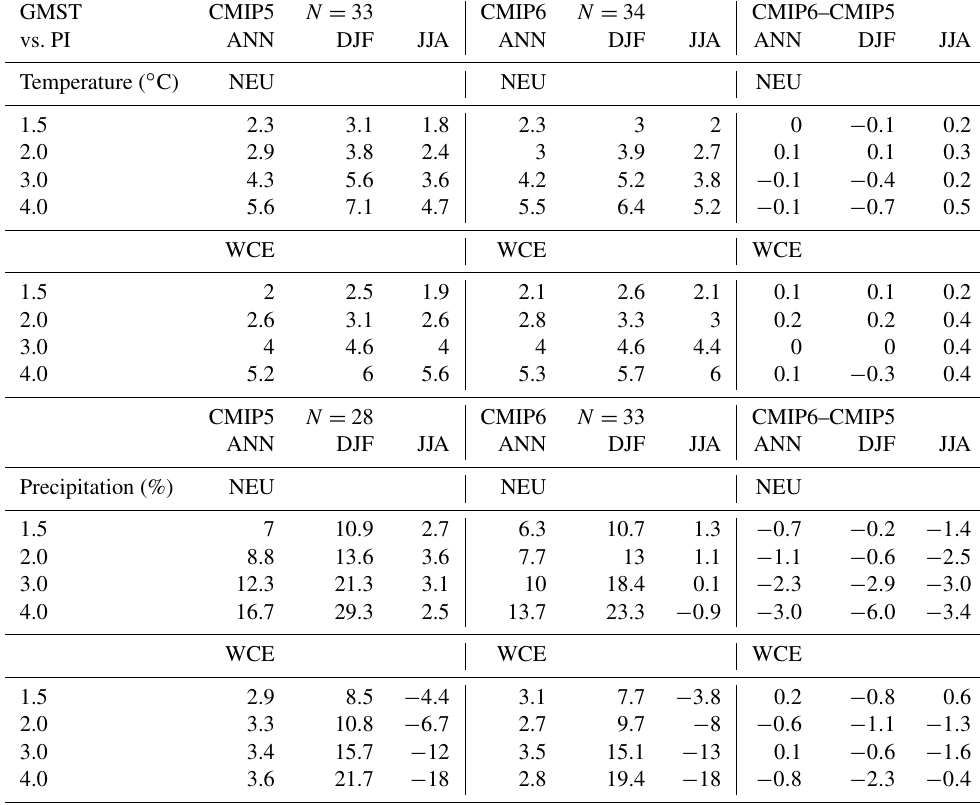
Table 6. Ensemble mean changes in temperature (degrees Celsius) and precipitation (percent) at selected future global mean surface tempera- ture (GMST) levels (1.5 to 4.0 ◦ C) compared to preindustrial (PI) conditions during 1850–1900. Listed are annual (ANN), winter (December to January – DJF), and summer (June to August – JJA) means from CMIP5, CMIP6, and their differences for northern Europe (NEU) and western and central Europe (WCE). N is the number of considered members in the two ensembles. Note that CMIP5 and CMIP6 are driven under RCP8.5 and SSP5-8.5 scenarios, respectively. Data source: IPCC AR6 Interactive Atlas; Iturbide et al., 2021; Gutiérrez et al.,